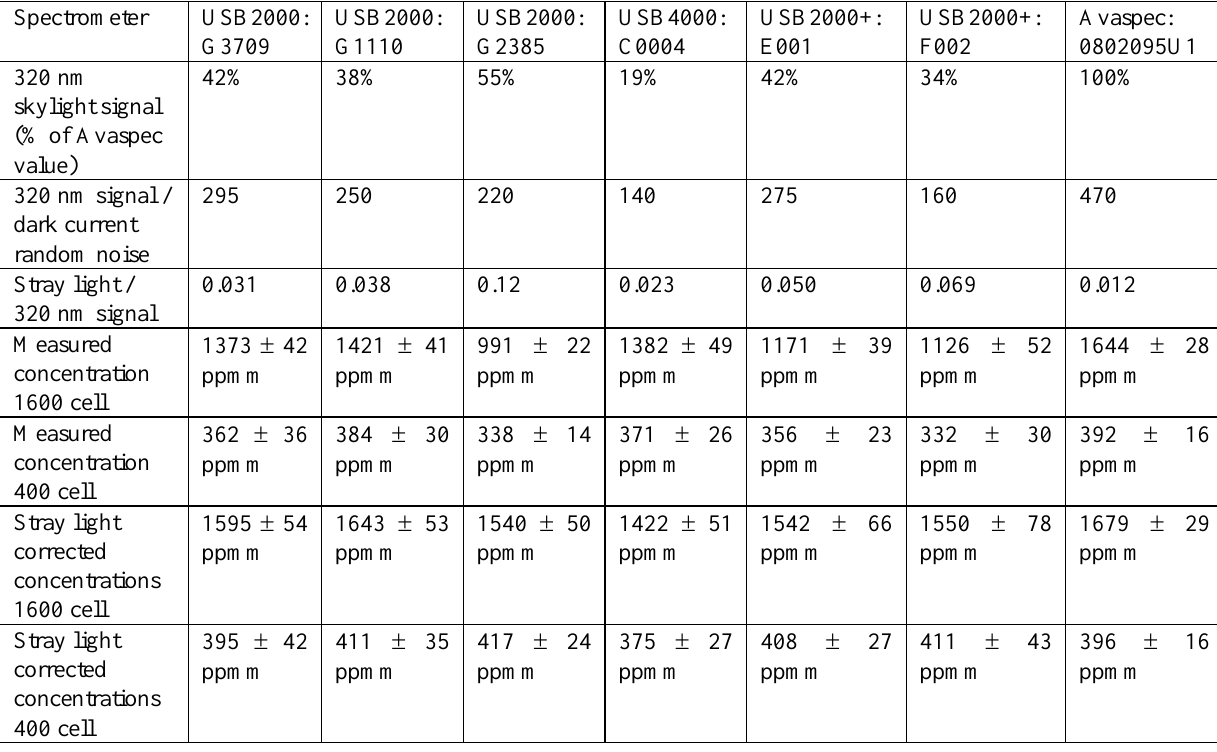
Table 1. Summary of the results of the investigations into the spectrometer characteristics reported in this paper for 170 ms integration time sky spectra. Full detail is supplied in the